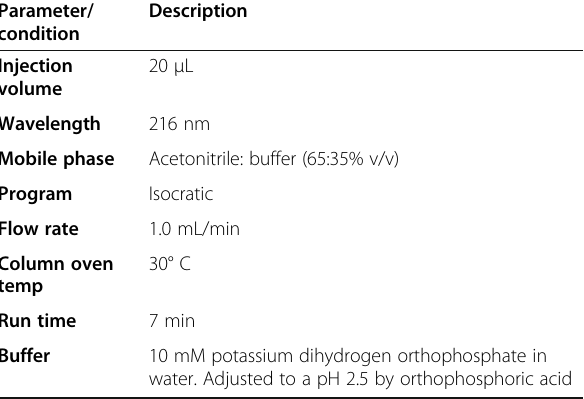
Table 2 Experimental results and selected method conditions Parameter/